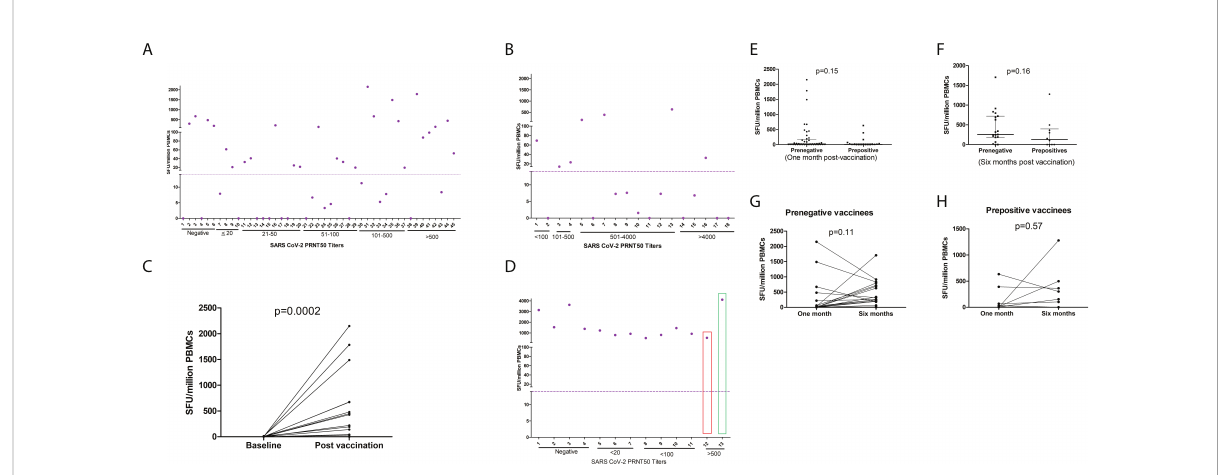
FIGURE 2 T cell responses to COVISHIELD and COVAXIN. Spike protein peptide-speci fi c T cell responses among (A) pre-vaccination IgG-anti-SARS-CoV- 2 negative COVISHIELD recipients (n = 45) and (B) pre-vaccination IgG-anti-SARS-CoV2 positive COVISHIELD recipients (n = 18). (C) IFN- g ELISpot responses in 16 pre-IgG negative COVISHIELD recipients prior to post-2nd dose vaccination. (D) Pre-vaccination IgG-anti-SARS-CoV-2 negative COVAXIN recipients (n = 12) and one IgG-anti-SARS-CoV-2 positive. One IgG negative recipient (Number 13, green rectangle) developed clinical COVID-19 post 2nd dose; sampled 3weeks post-diagnosis. Before vaccination, the pre-positive vaccinee (Number 12) had PRNT titer of 119 that increased to 469 post-second dose). Purple circles (IFN- g ELISpot, Spot forming Units/million PBMCs), depict corresponding values for the individual patients. Dotted line show cut off values for IFN- g ELISpot. ELISpot=Enzyme-Linked Immunospot; PBMC=peripheral blood mononuclear cells. Comparison of T cell response (IFN- g ELISPOT) (Mann Whitney U test) between prepositives and prenegatives (E) at one month of postvaccination (F) at six months of postvaccination Comparison of T cell responses (Wilcoxon signed rank sum test) at one month and six months post vaccination (G) Prenegative vaccinees (H) Prepositive